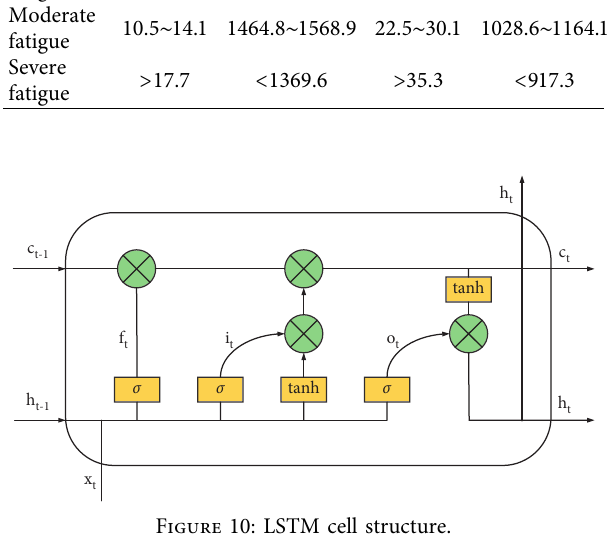
Figure 10: LSTM cell structure.